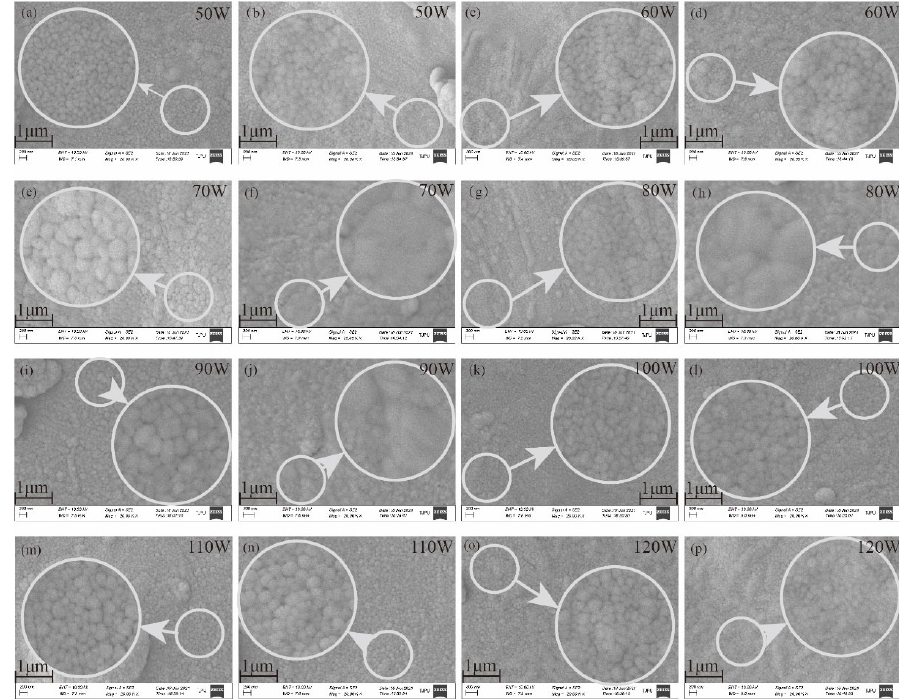
Figure 9. ( a ) SEM of Ag layer before heat treatment at 50 W; ( b ) SEM of Ag layer after heat treatment at 50 W; ( c ) SEM of Ag layer before heat treatment at 60 W; ( d ) SEM of Ag layer after heat treatment at 60 W; ( e ) SEM of Ag layer before heat treatment at 70 W; ( f ) SEM of Ag layer after heat treatment at 70 W; ( g ) SEM of Ag layer before heat treatment at 80 W; ( h ) SEM of Ag layer after heat treatment at 80 W; ( i ) SEM of Ag layer before heat treatment at 90 W; ( j ) SEM of Ag layer after heat treatment at 90 W; ( k ) SEM of Ag layer before heat treatment at 100 W; ( l ) SEM of Ag layer after heat treatment at 100 W; ( m ) SEM of Ag layer before heat treatment at 110 W; ( n ) SEM of Ag layer after heat treatment at 110 W; ( o ) SEM of Ag layer before heat treatment at 120W; ( p ) SEM of Ag layer after heat treatment at 120 W. Figure 10 shows EDS testing results of Ag temperature sensing layers at 90 W. The testing was carried out when the Ag layers was placed for a long time. It can be seen from Figure 10 that a large amount of Ag nanoparticles(98.88 wt.%) had been deposited on the surface of the substrate, and the layers contained a few O(0.5 wt.%) and N(0.62 wt.%)